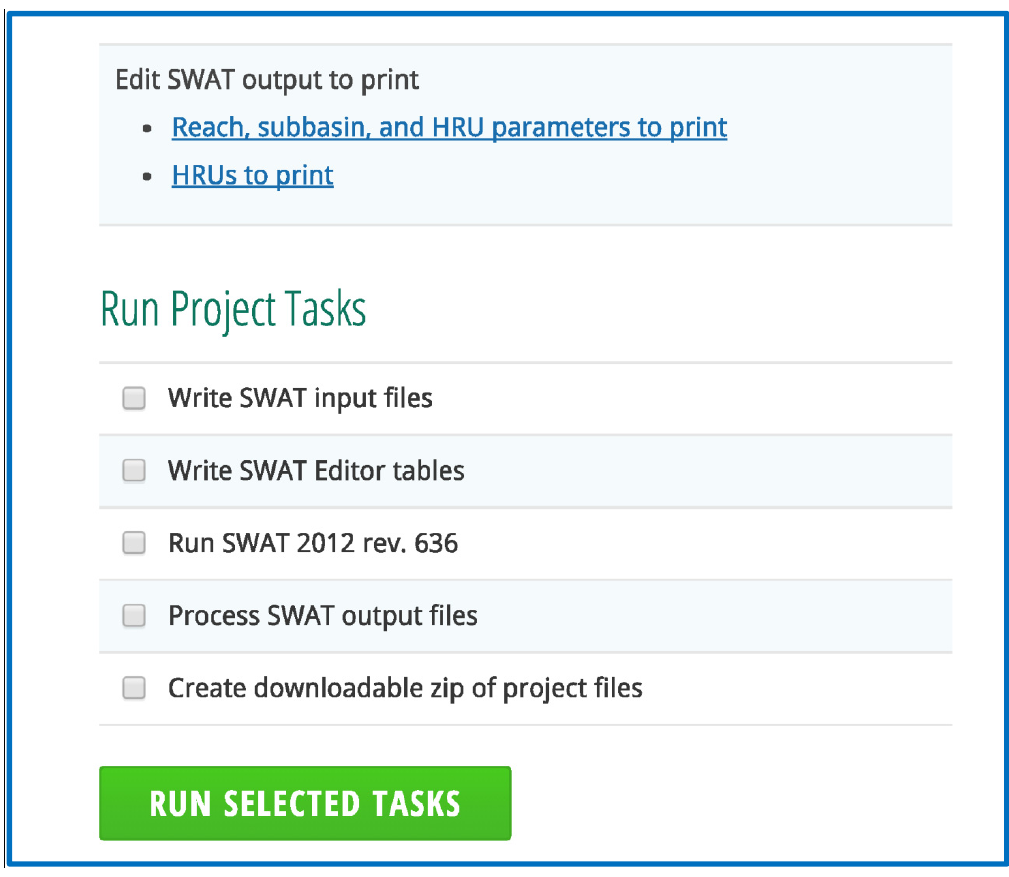
Figure 5. Output management: (i) reach/subbasin/HRU parameters; (ii) HRU output variables; and (iii) execution of the SWAT project.